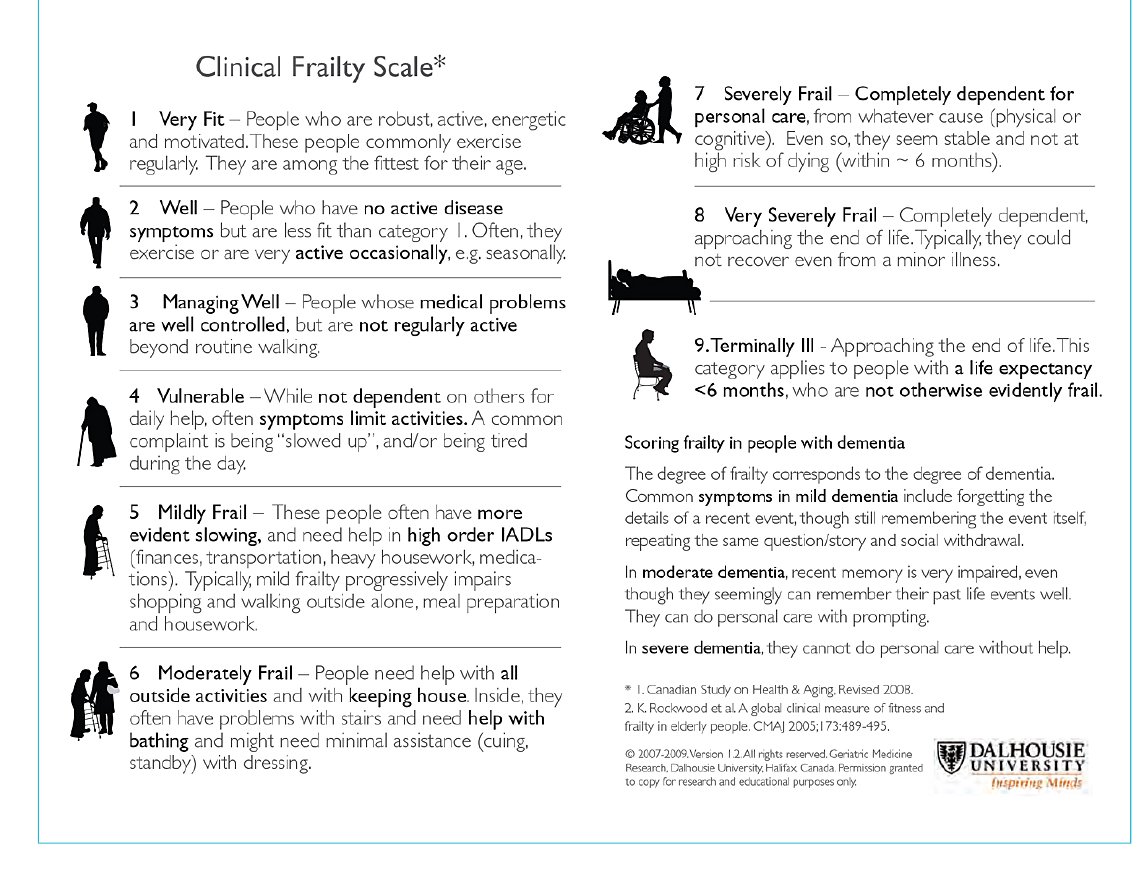
Figure S1: Clinical Frailty Scale